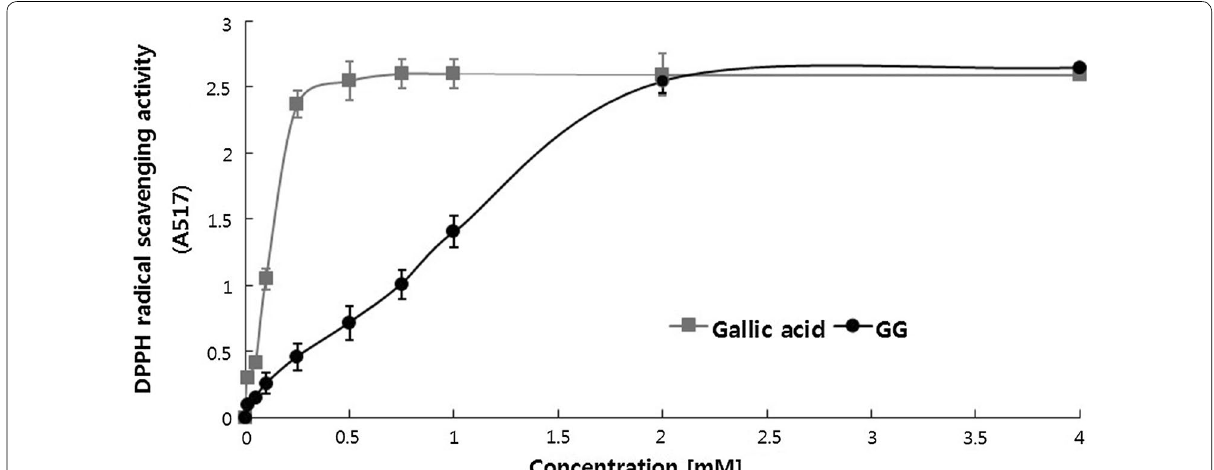
Fig. 3 The DPPH radical‑scavenging activity of gallic acid and gallic acid glucoside. The concentrations of 0, 0.01, 0.05, 0.1, 0.25, 0.5, 0.75, 1.0, and 2.0 mM were tested, and the reaction was monitored at 517 nm. The data are reported as mean